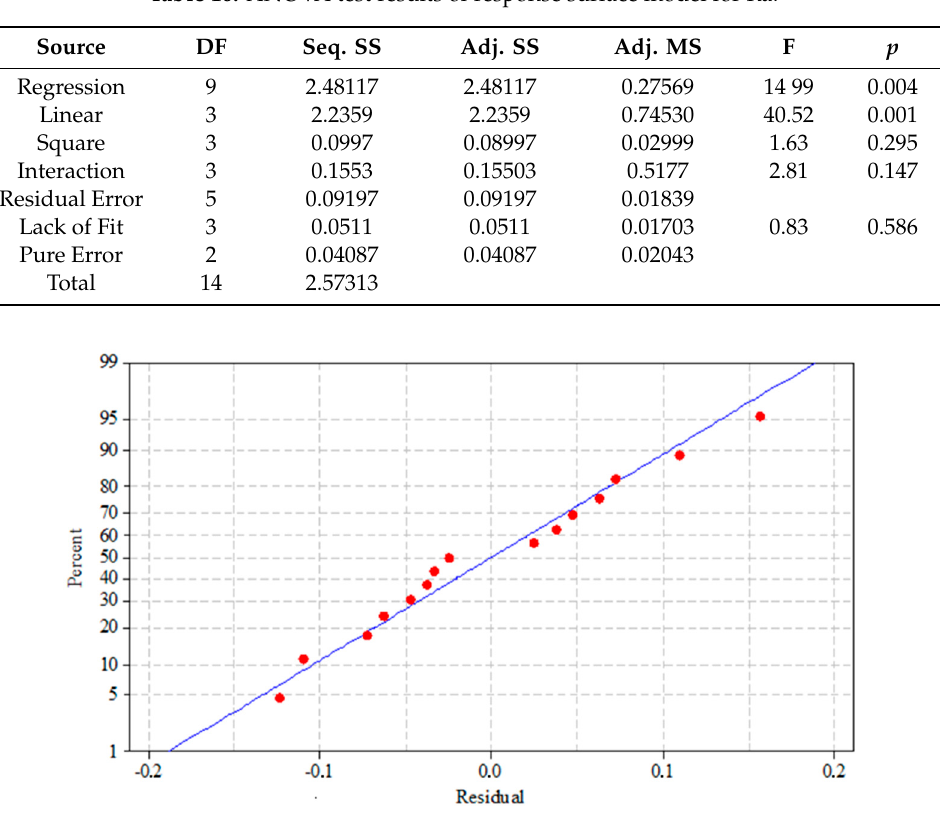
Figure 7. Normal probability plot of the residuals for surface roughness parameter of Ra.